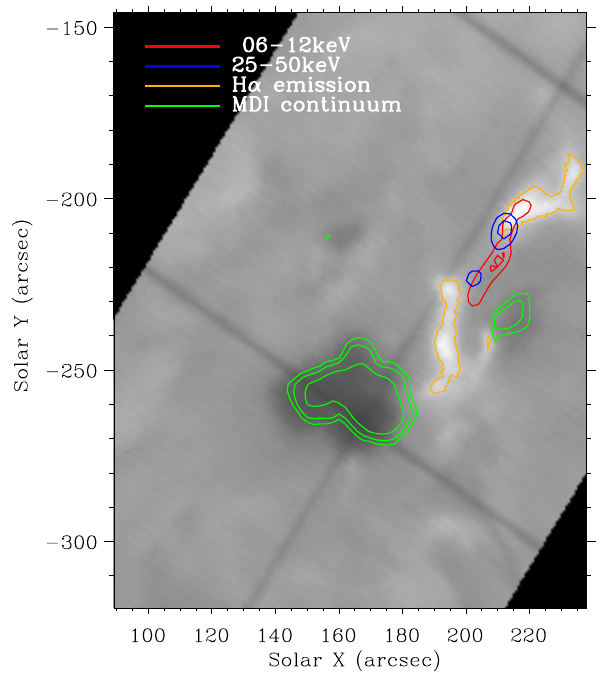
Fig. 5. The H α slit-jaw image at 09:57:45UT overlaid by the MDI continuum spots and the HXR sources reconstructed in 09:56:31–